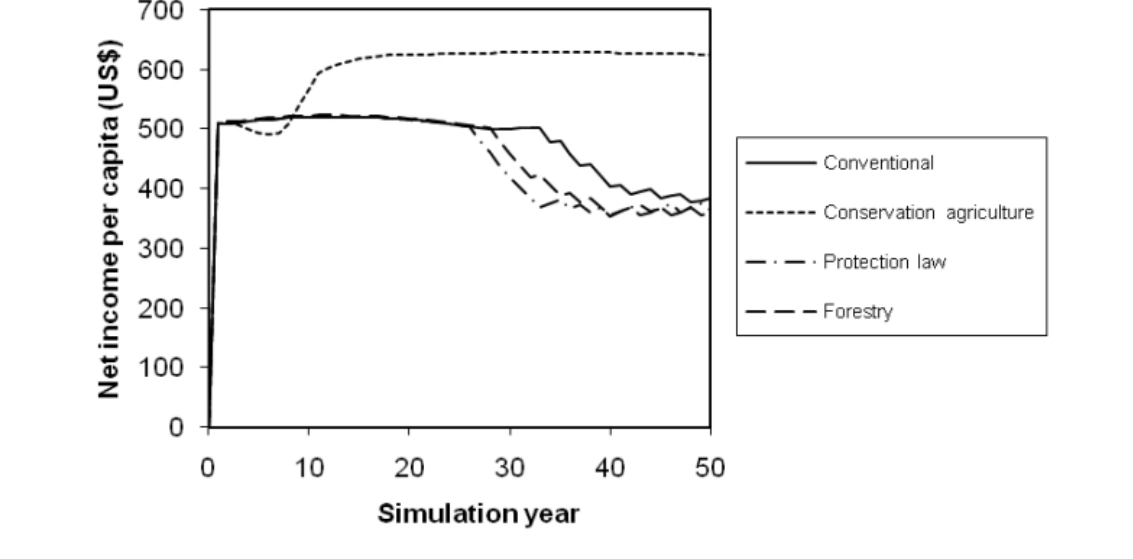
Fig. 5 . Simulated net income per capita generated by agriculture and forestry in the Cuenca under four land use